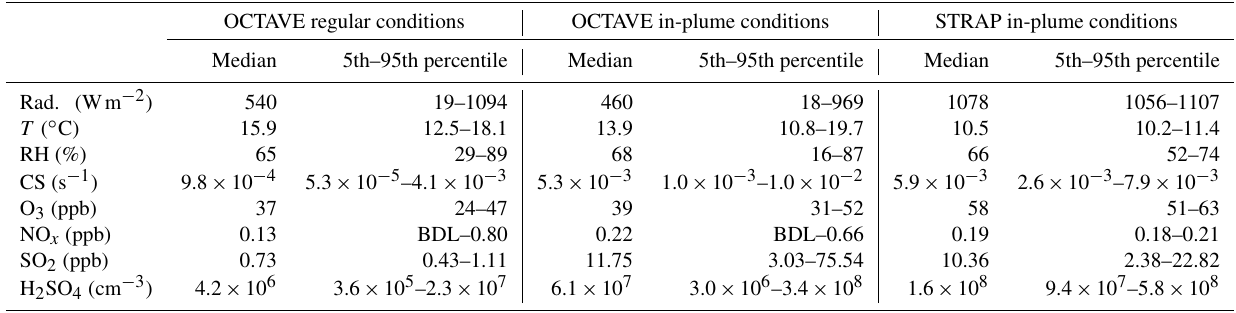
Table 1. Median and 5th and 95th percentiles of key atmospheric variables measured during daytime under regular and plume conditions during OCTAVE, and under plume conditions during the first part of the ETNA 13 flight